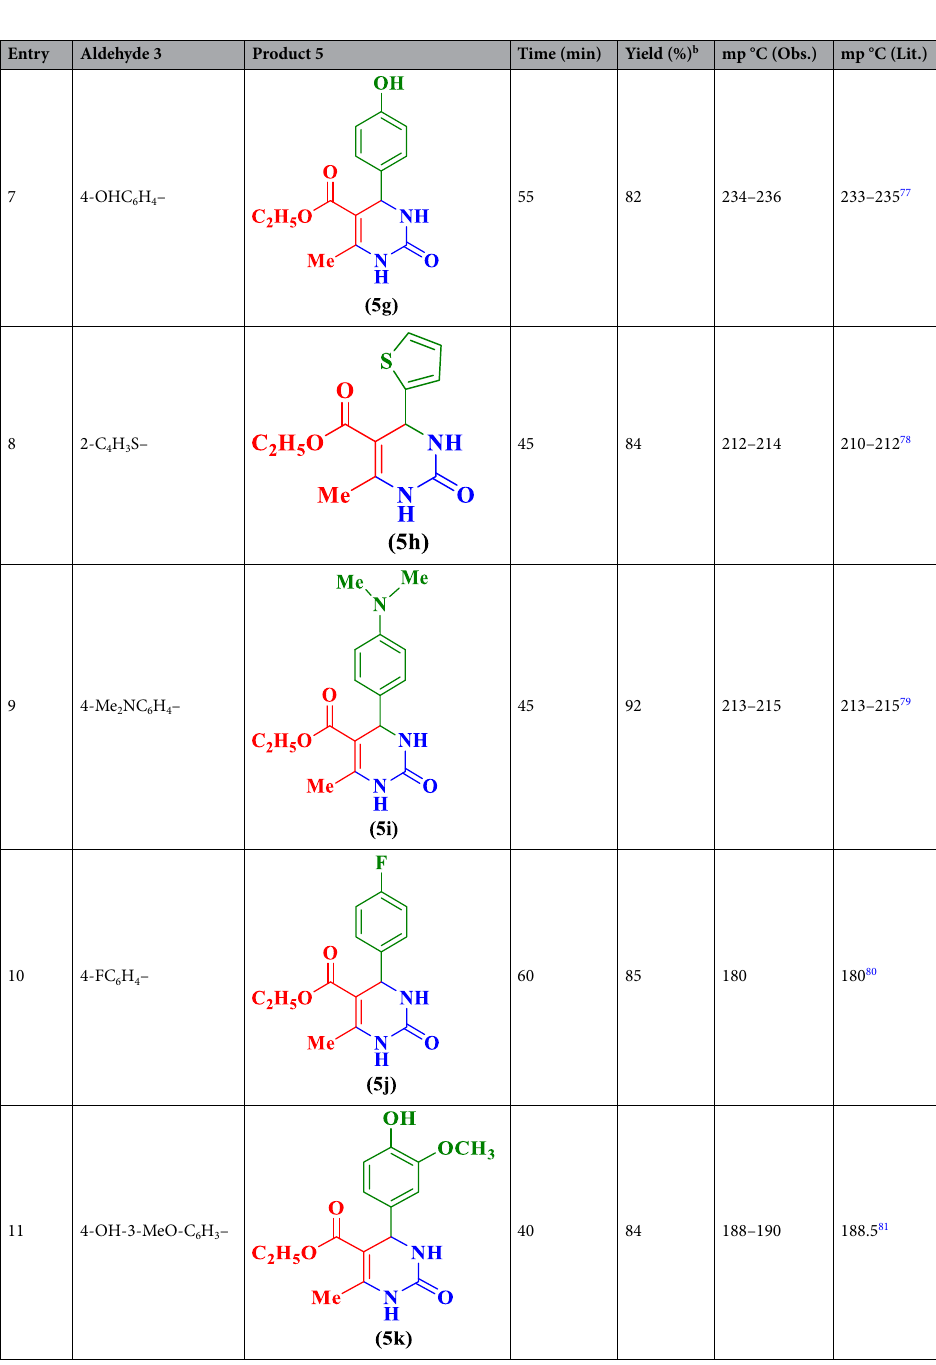
Table 2. Scope of the Biginelli condensation for the synthesis of 3,4-dihydropyrimidin-2-(1 H )-ones catalyzed by